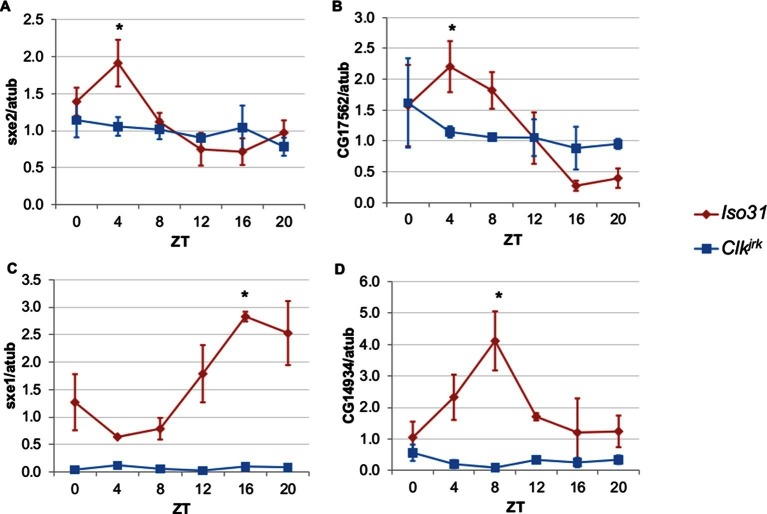
Rhythmic expression of genes that cycle independently of the fat body clock requires clocks in other tissues.Daily oscillations of several fat body clock-independent genes were tested in male mutants lacking functional clocks in all tissues, Clkjrk mutants, in LD. Rhythmicity of sxe2 (A), CG17562 (B), sxe1 (C), and CG14934 (D) is abolished in Clkjrkmutants but is intact in Iso31 wild type controls. All genes were normalized to α−tubulin (atub) levels. Each experiment was repeated independently three times. The average value for each timepoint is plotted with error bars denoting SEM. JTK_cycle p value <0.05 is indicated by an asterisk (*) at the time of peak expression. See Table 3 for JTK_cycle p values. ZT- Zeitgeber Time.DOI:
http://dx.doi.org/10.7554/eLife.13552.00710.7554/eLife.13552.008Figure 2—source data 1.Data for qPCR analysis of fat body clock-independent genes in Clkjrk mutants.